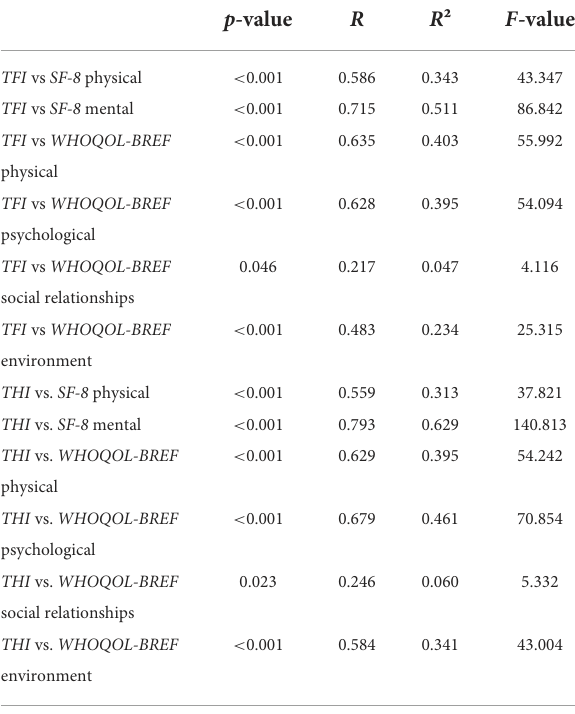
TABLE 3 Linear regressions between the tinnitus questionnaires and all subdomains of the HRQoL questionnaires.